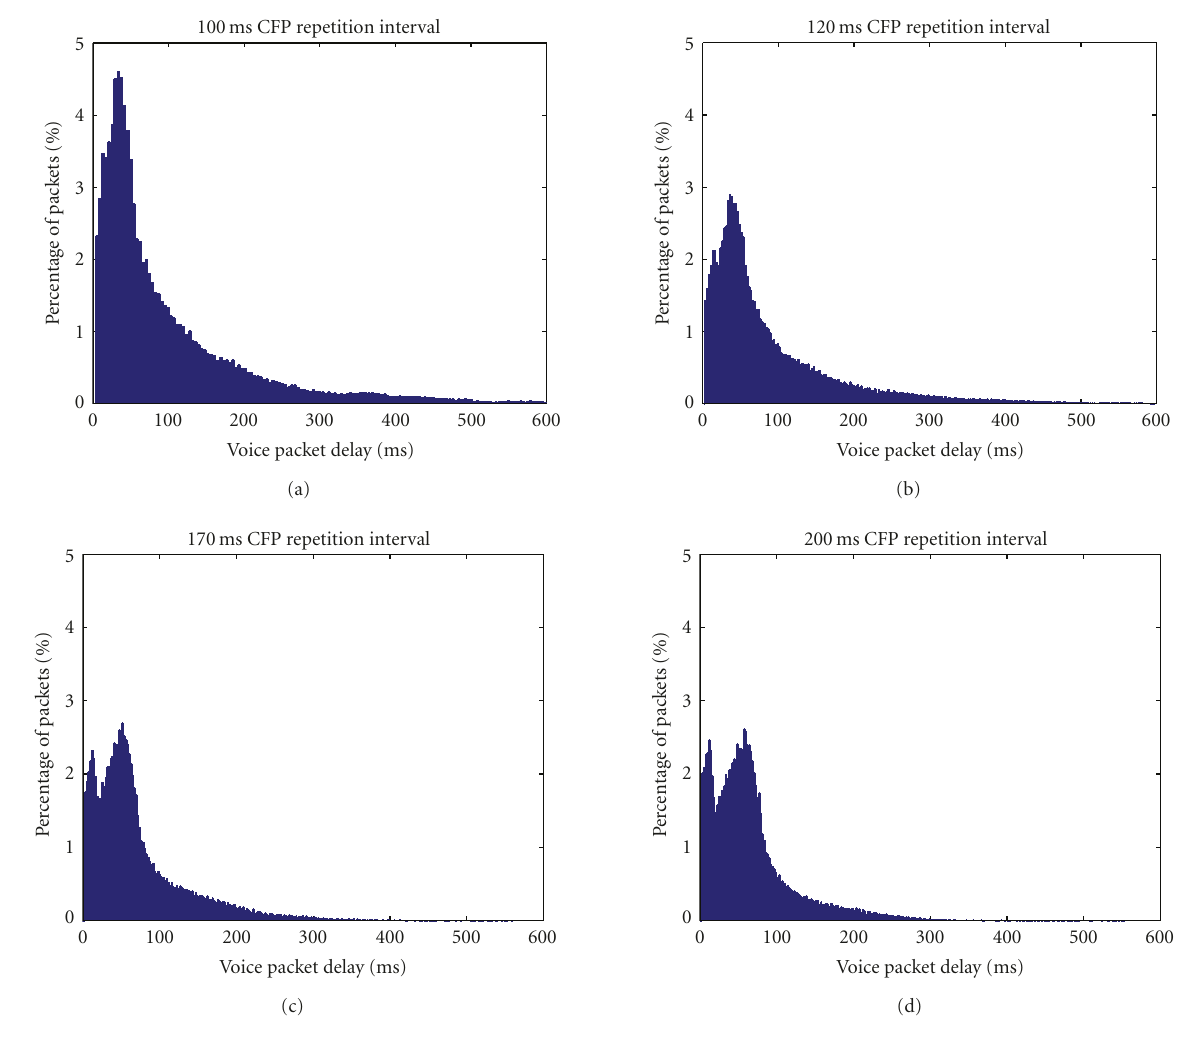
Figure 6: PDFs of voice packet delays at 70% CFP MAX